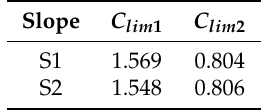
Table 4. Summary of Fs values obtained for slope 1 (S1) and slope 2 (S2), for the water table conditions